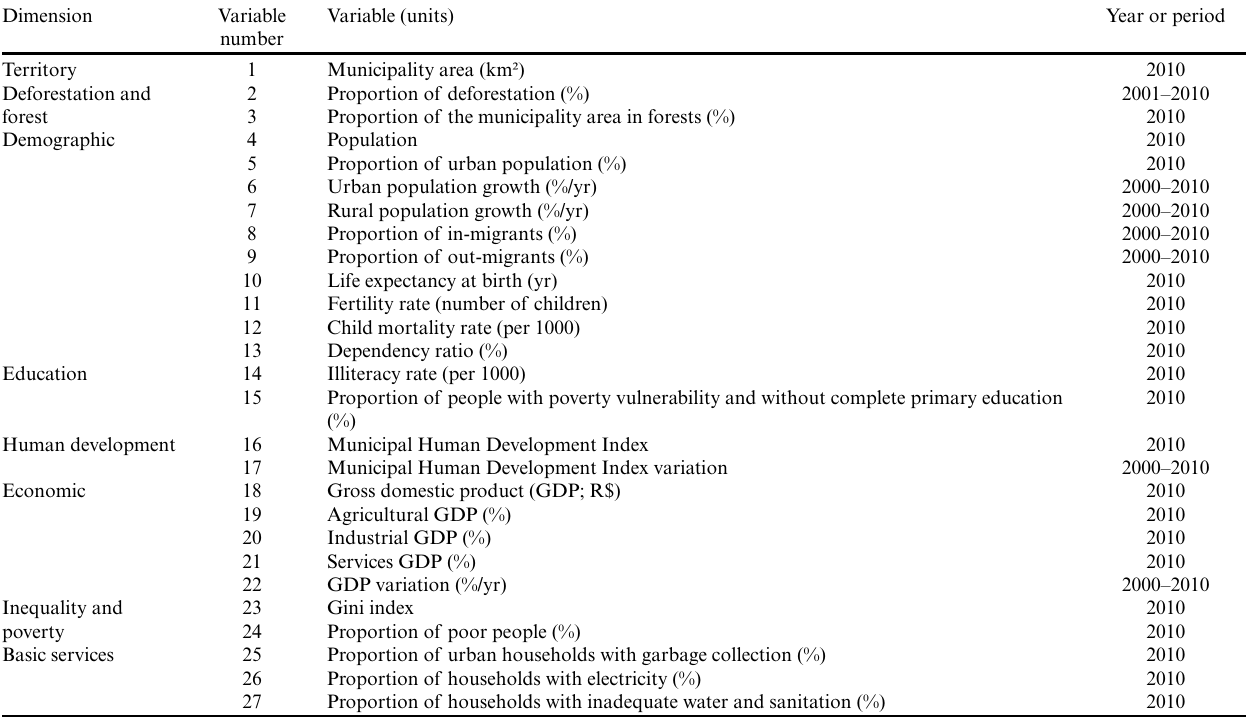
Table 1. List of initial variables, 2000–2010. Sources: INPE (2014), IBGE (2000, 2010), and PNUD (2013).